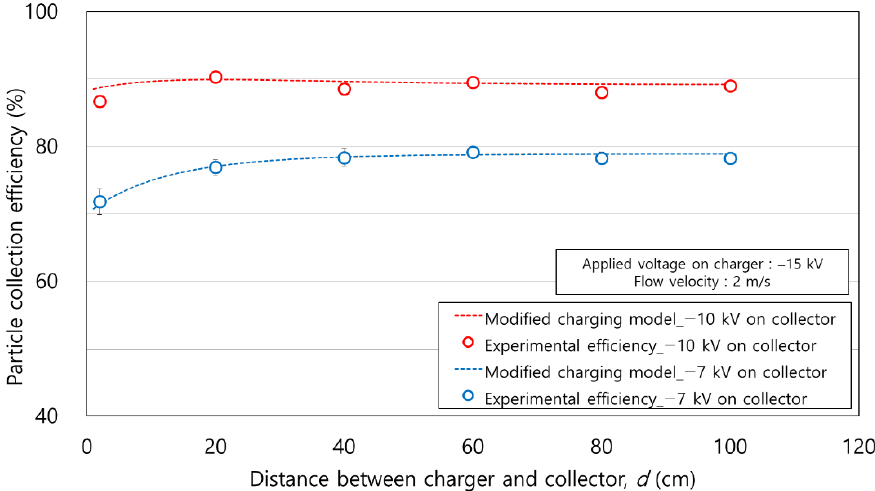
Figure 13. Comparison of the experimental efficiency and modified charging model according to the distance between charger and collector. distance between charger and